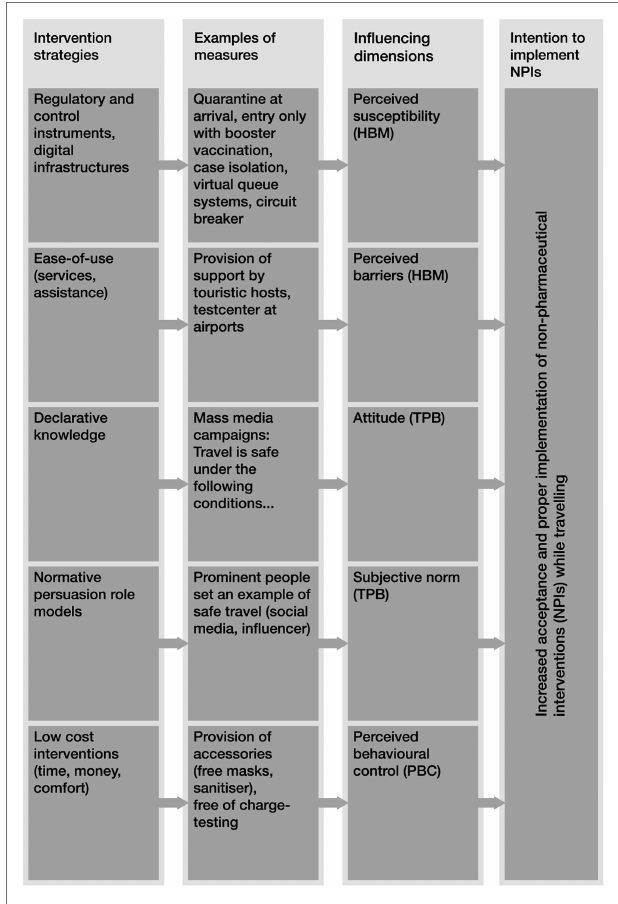
FIGURE 4 | Presentation of exemplary measures for addressing social- psychological influencing